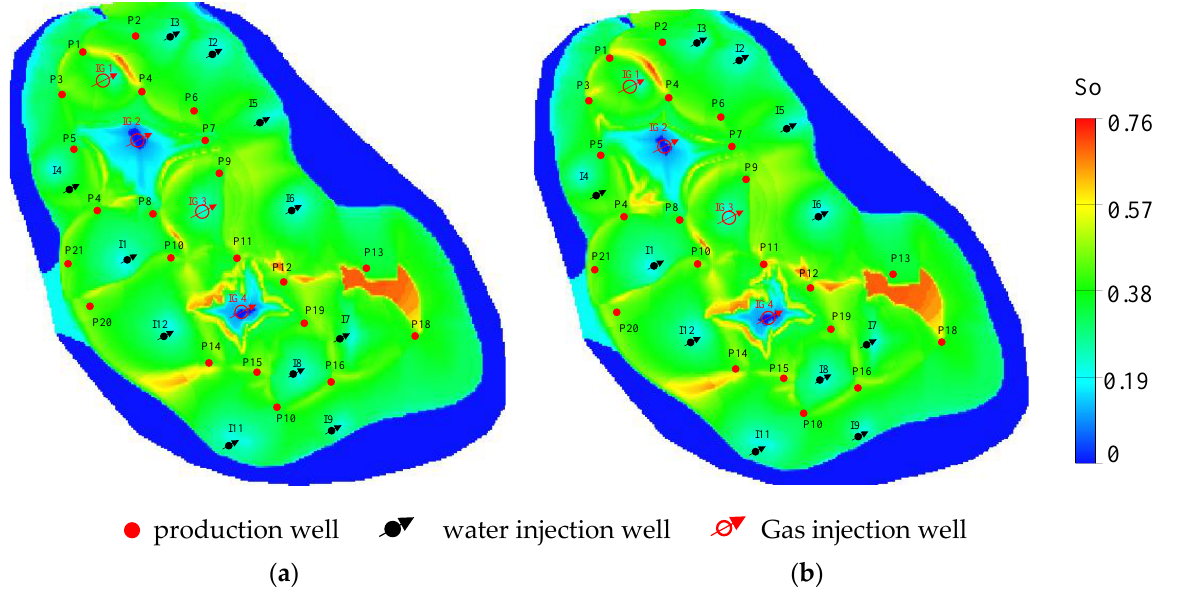
Figure 11. Comparison of oil saturation after well control optimization using ( a ) conventional numerical simulation and ( b ) the Deep-LSTM proxy model.